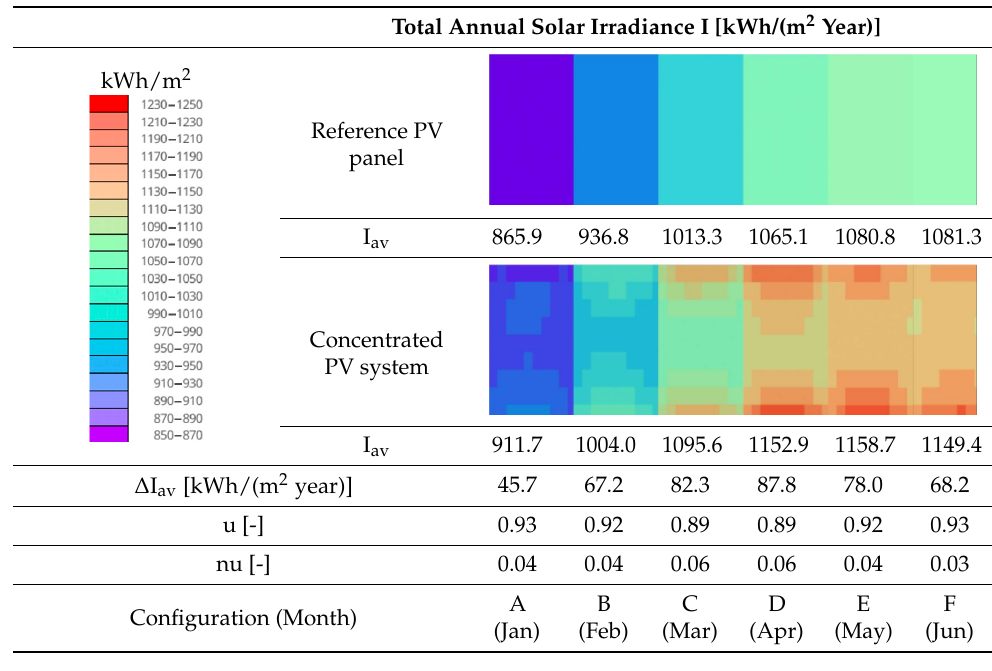
Table 5. Solar irradiance characteristic for A–F cases of PV panels positioned vertically.